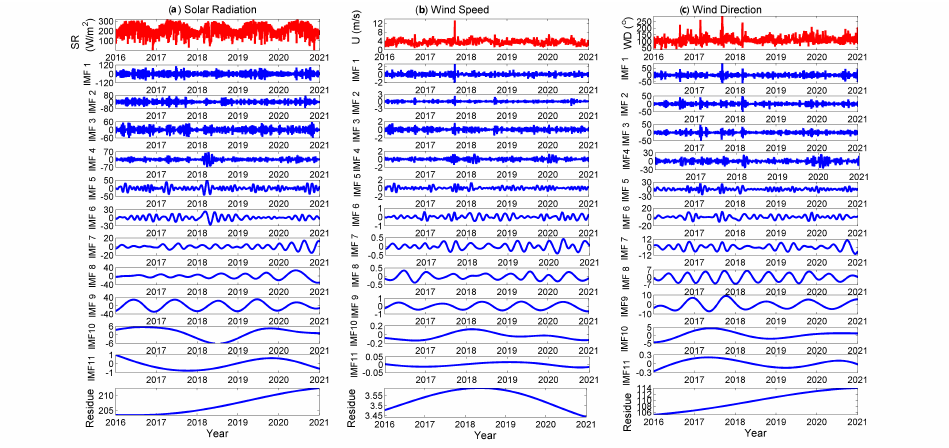
Figure 4. Results of the decomposition of different variables using the MEMD analysis for ( a ) solar radiation ( SR ); ( b ) wind speed ( U ) and ( c ) wind direction ( WD